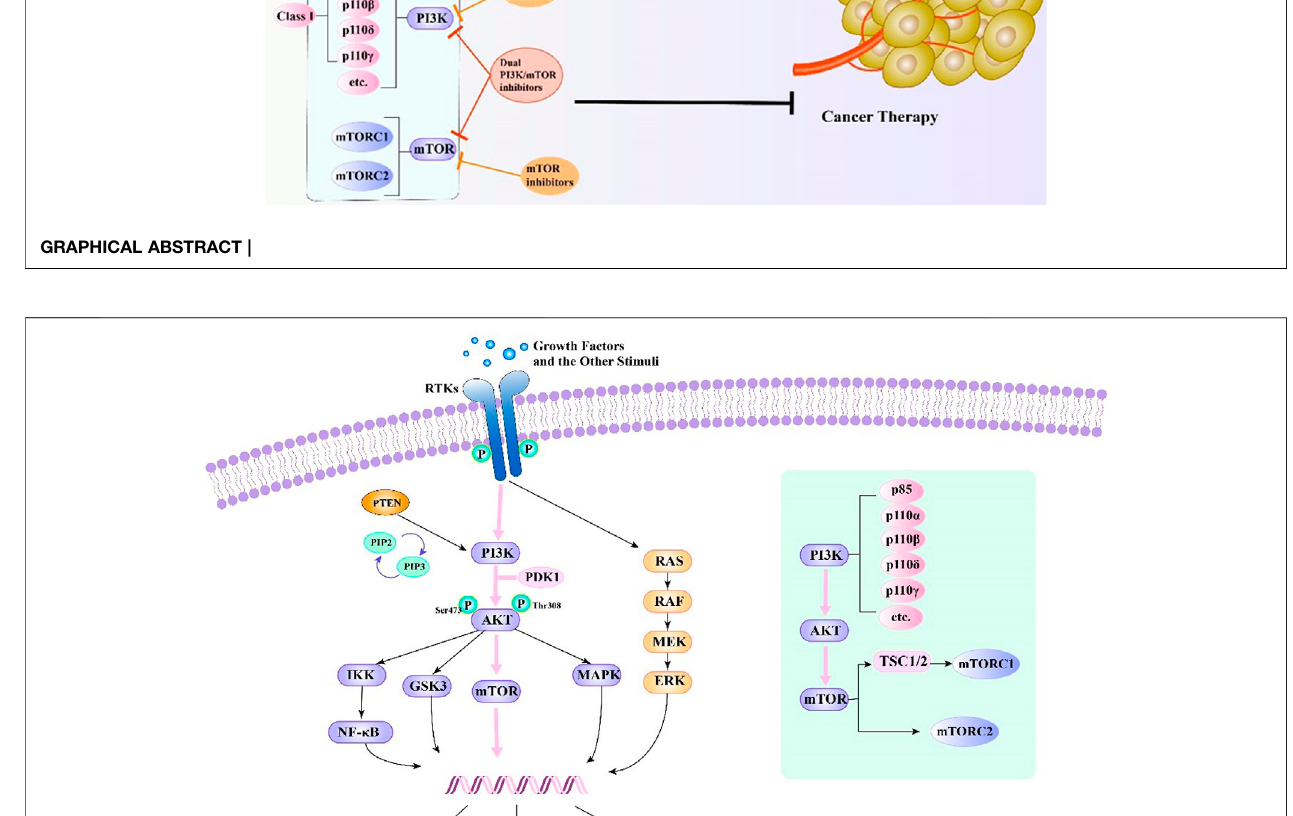
Frontiers in Pharmacology |